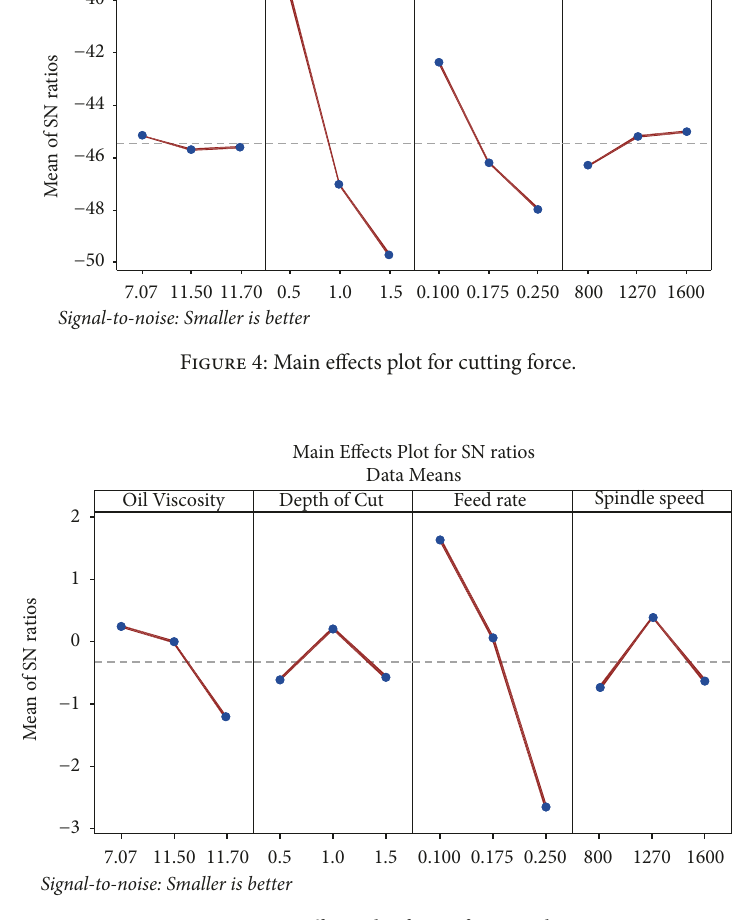
Figure 5: Main effects plot for surface